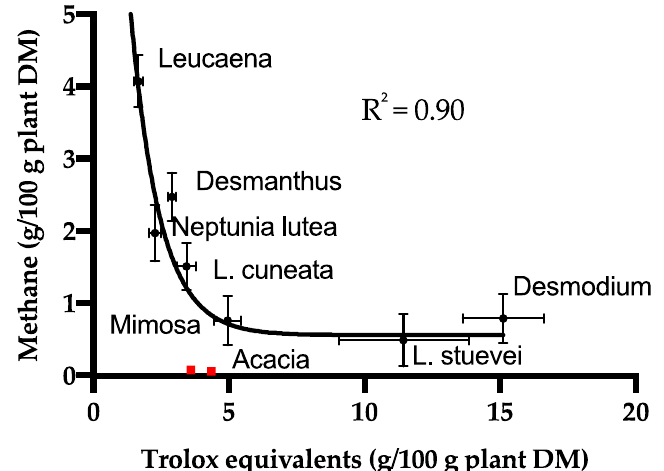
Figure 3. Relationship between methane production [23] and antioxidant activity for the forages. The non-linear exponential fit (Y = 11.64(exp( − 0.772X)) + 0.6433) does not include the Acacia CT data (red markers). The points are average for the ORAC method ( n = 3) and the in vitro gas production ( n = 3) and the error bars indicate standard deviations.